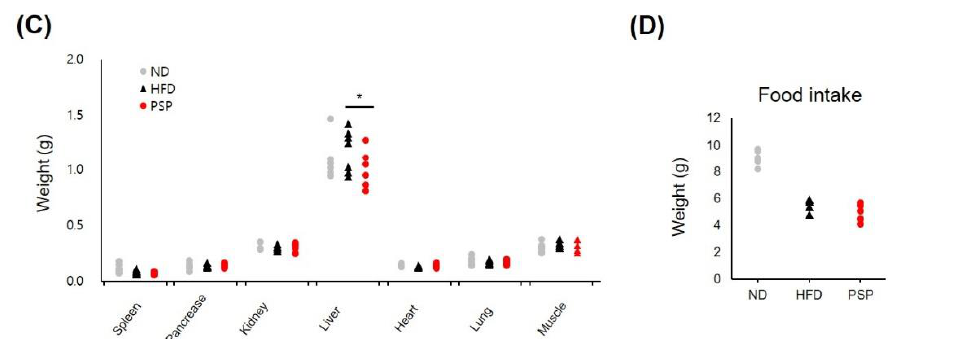
Figure 1. Effects of PSP on body weight gain, adipose expansion, and food intake in mice with HFD-induced obesity: The ND group ( n = 7) was fed a normal diet, HFD control group ( n = 7) was fed an HFD, and PSP-treated group (PSP) ( n = 7) was fed an HFD plus PSP at 100 mg/kg/day. The ND and HFD control groups were given the same volume of water. ( A ) The body weight for 7 weeks. ( B ) The weight of adipose tissues, including BAT, iWAT, eWAT, and rWAT ( n = 7/group). ( C ) The weight of the liver, heart, spleen, pancreas, lung, muscle, and kidney ( n = 7/group). ( D ) Food intake was recorded every week throughout the study ( n = 6/group). * p < 0.05, significant difference compared with HFD group. Bar graphs show mean ± SD of each group.